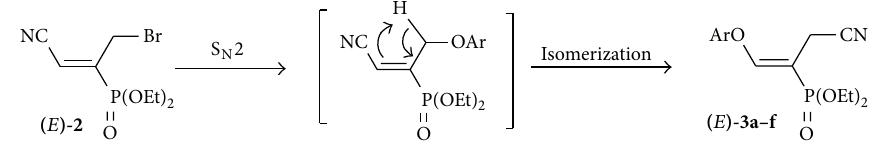
Scheme 3: Isomerization of allyl ethers to the corresponding vinyl ones 3 .